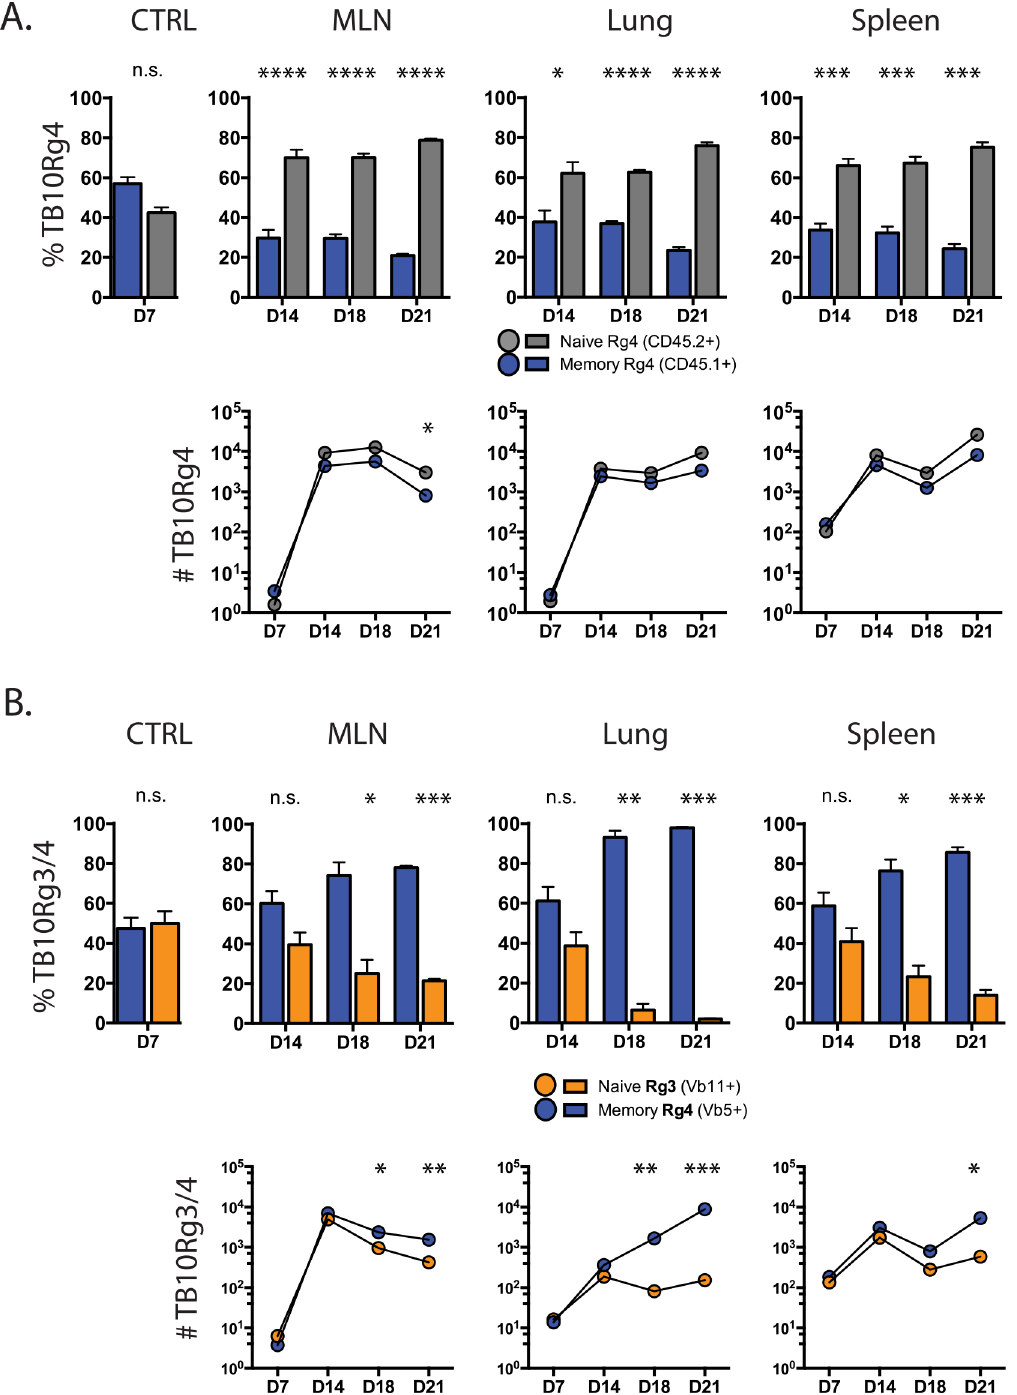
Fig 6. Memory CD8 + T cells with a higher affinity TCR can display improved responses during tuberculosis. (a) Proportion of adoptively- transferred memory (CD45.1 + ) and na ï ve (CD45.2 + )-derived TB10Rg4 CD8 + T cells in the MLN, lung, and spleen 14, 18, or 21d after Mtb infection, compared to spleens from uninfected mice 1 day after adoptive transfer (CTRL) (top). Cell numbers of memory and na ï ve-derived TB10Rg4 CD8 + T cells from the same mice (bottom). (b) The relative proportion of adoptively-transferred, memory-derived TB10Rg4 (V β 5 + ) and na ï ve-derived TB10Rg3 (V β 11 + ) CD8 + T cells in the MLN, lung, and spleen 14, 18, or 21d after Mtb infection, compared to those in the spleens of uninfected mice 1 day after adoptive transfer (CTRL) (top). Cell numbers of memory-derived (TB10Rg4) and na ï ve-derived (TB10Rg3) CD8 + T cells from the same mice at each time point during infection (bottom). * p < 0.05, ** p < 0.01, *** p < 0.001, **** p < 0.0001, n.s. not significant. Data are representative of 2 independent experiments, each with 4 mice per